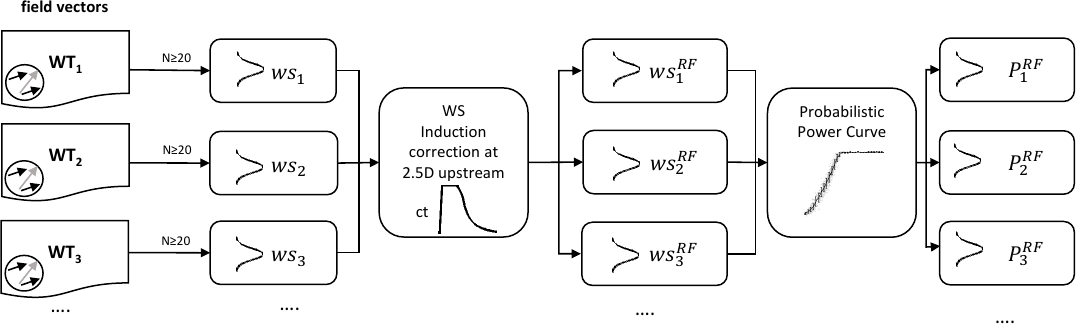
Figure 4. Scheme of the remote sensing probabilistic forecasting model (RF) showing the unmodified wind speed predictive densities ( ws i ), the wind speed densities after correcting for induction effects ( ws RF ) and the predictive densities of power ( P RF i i